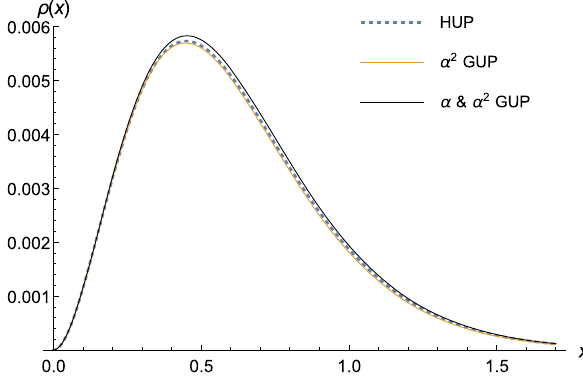
Fig. 6 The total energy density ρ( x ) versus the variable x for massless bosons in a general static spherically symmetric spacetime, where a = 0 . 01